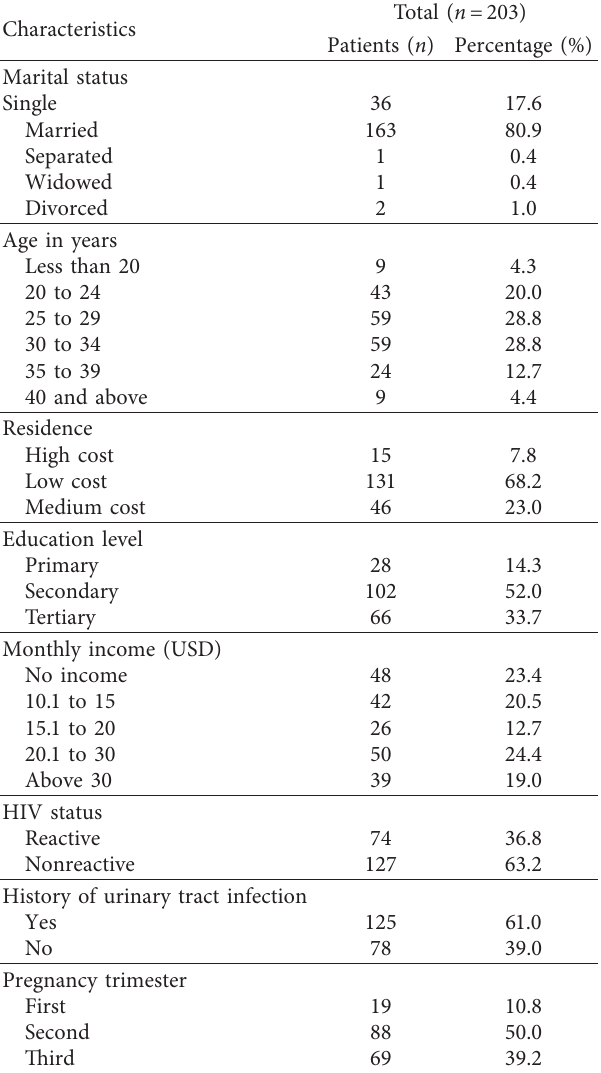
Table 1: Sociodemographic characteristics of study participants at Levy Mwanawasa University Teaching Hospital ( n �